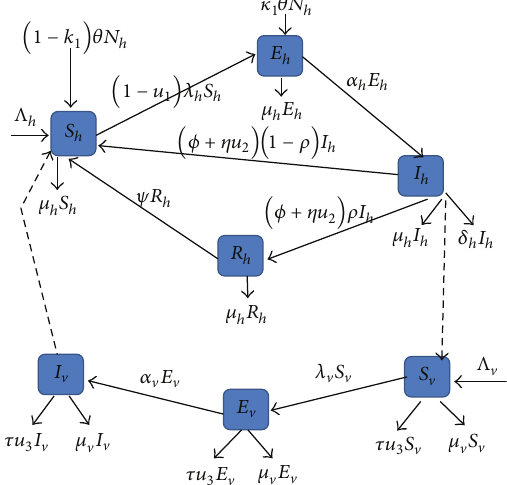
Figure 1: The malaria model with interventions flowchart.